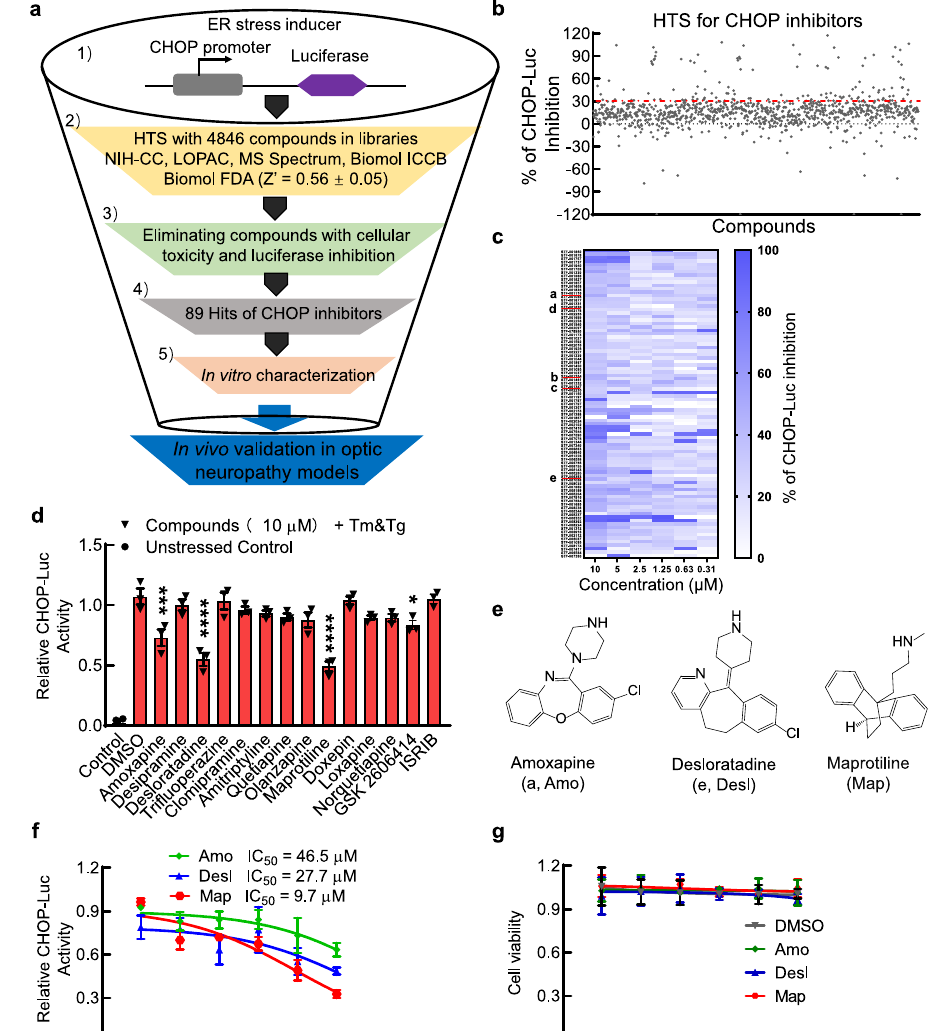
Fig.1|Cell-basedHTStoidentifysmallmoleculeinhibitorsoftheCHOPbranch of UPR. a The schematic HTS pipeline employed to identify small molecules that inhibit the CHOP pathway of the ER stress with the HEK293T reporter cell line expressing CHOP promoter-driven luciferase (CHOP-Luc)and downstreaminvitro and in vivo assays for further characterization. b Plot showing the percentage inhibition of CHOP-Luc signals of each tested librarycompound in the presenceof Tm/Tg (1 µ M), 24h after exposure. “ Hit ” threshold is set at >30% inhibition (red dotted line) but <100% inhibition. c Heatmap of dose-dependent responses of 89 “ hits ” in CHOP-Luc inhibition. Compounds a – e with similar chemical structure are marked with red lines. d Relative (to DMSO) CHOP-Luc activities of 12 compounds and 2 control compounds GSK2606414 and ISRIB at 10 µ M in the presence of Tm/